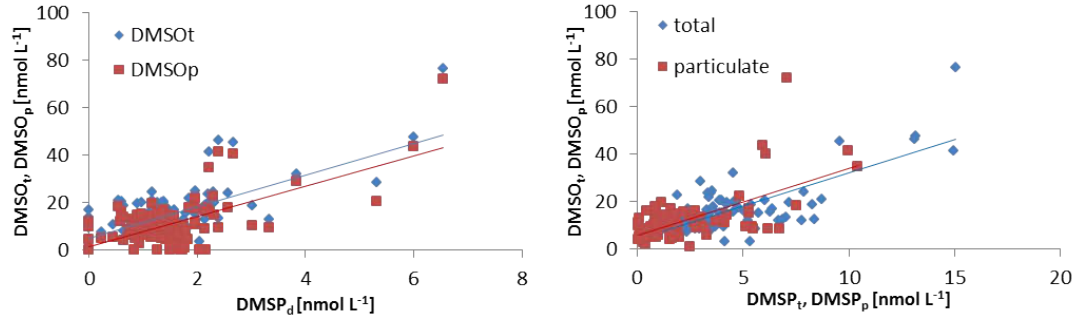
Fig. 4. Left panel: linear regression between DMSP d and DMSO t : y = 6 . 66 x + 5 . 06, R 2 =0.33, p value: 1.414e − 10 , F statistic: 50.86, n =105, and between DMSP d and DMSO p : R 2 =0.35, y = 6 . 41 x + 1 . 42, p value: 6.493e − 11 , F statistic: 53.53, n =102, both regressions for the entire data set. Right panel: linear regression between DMSP t and DMSO t : y = 2 . 84 x + 4 . 28, R 2 =0.47, p value: 9.613 e − 16 , F statistic: 90.87, n =104 and between DMSP p and DMSO p , y = 2 . 84 x + 5 . 68, R 2 = 0 . 41, p value: 5.849e − 11 , F statistic: 56.54, n =85, both regressions for the entire data set.